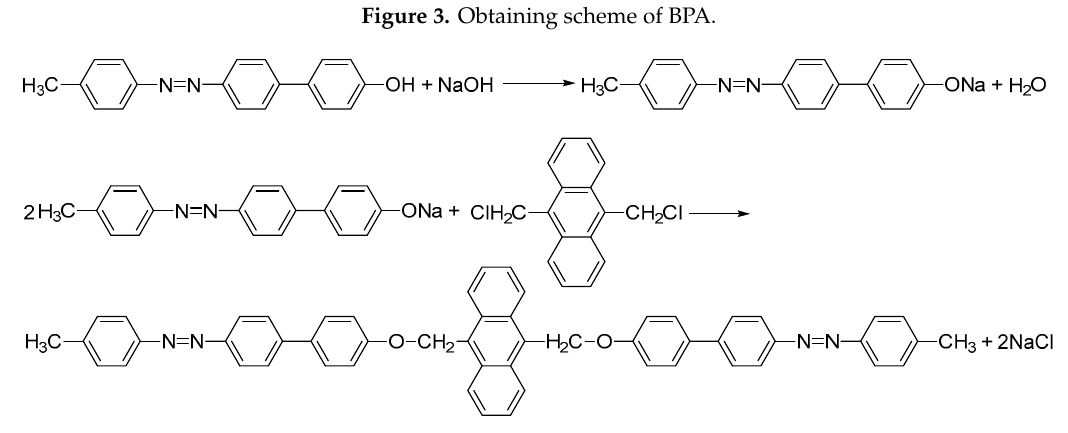
Figure 3. Obtaining scheme of BPA.